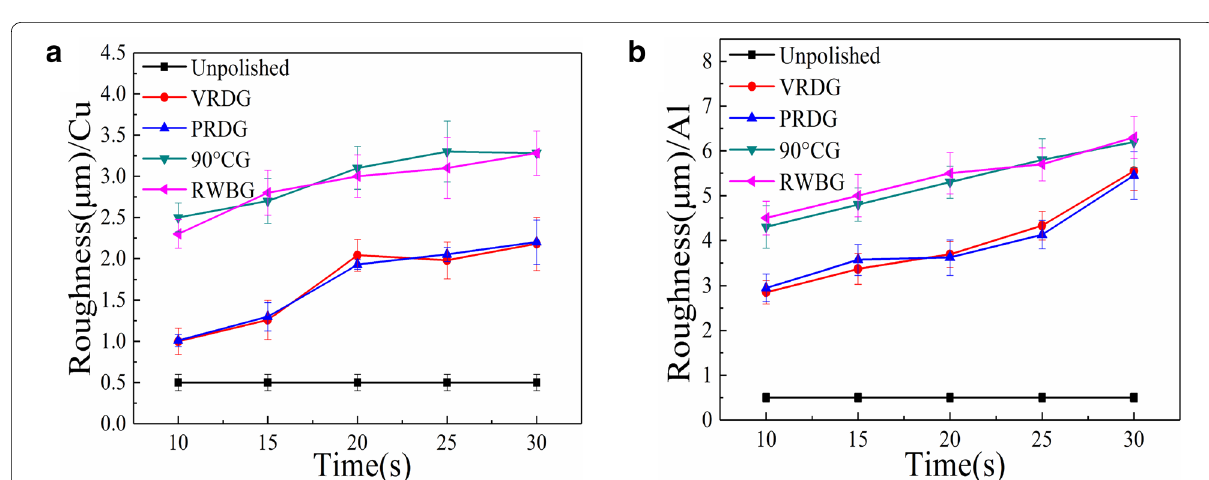
Fig. 5 Surface roughness with different mechanical treatments: a Cu plate; b Al